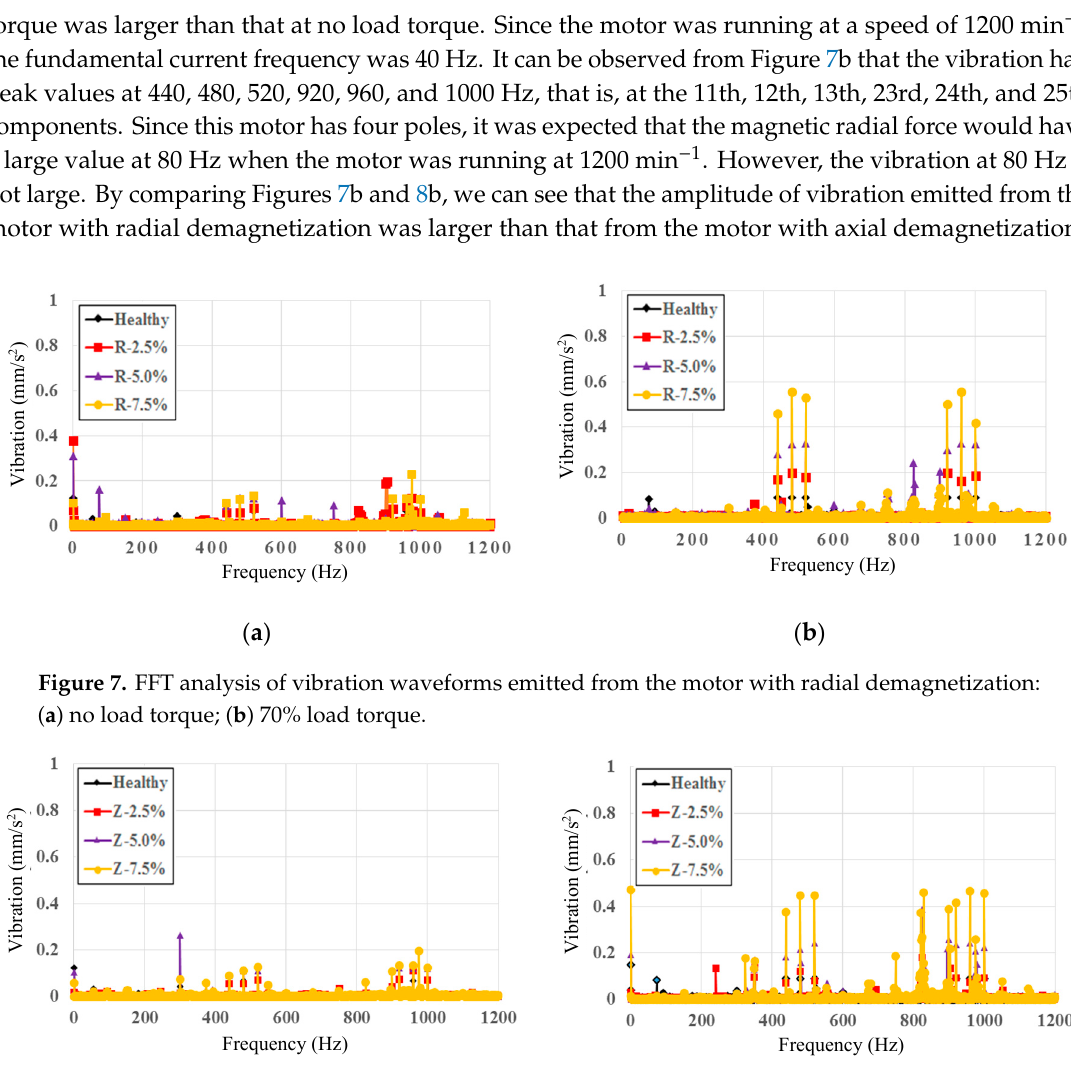
Figure 6. Vibration waveforms at 70% load torque: ( a ) healthy motor; ( b ) R-7.5% motor; ( c ) Z-7.5% motor.